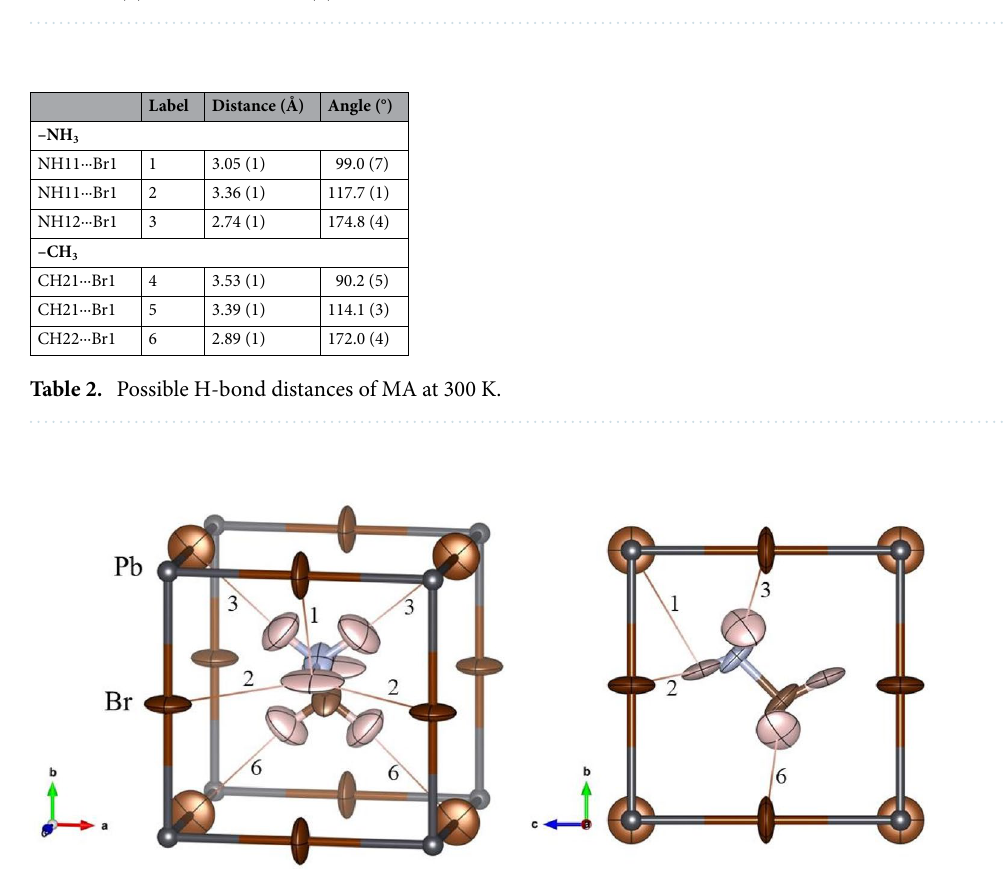
Table 1. Crystallographic data for MAPbBr 3 phase in cubic system ( Pm 3 m ) from single crystal ND at 298 K.